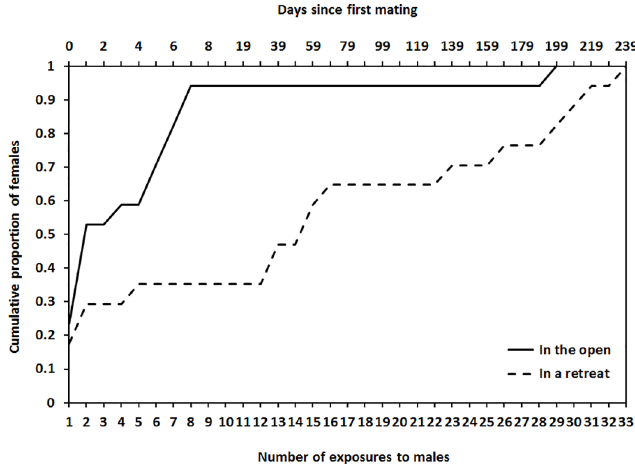
Fig 2. Cumulative proportionof once-mated female Servaea incana that remated followingrepeated exposureto males (a) in the open ( N = 17) or (b) in a retreat ( N = 17).